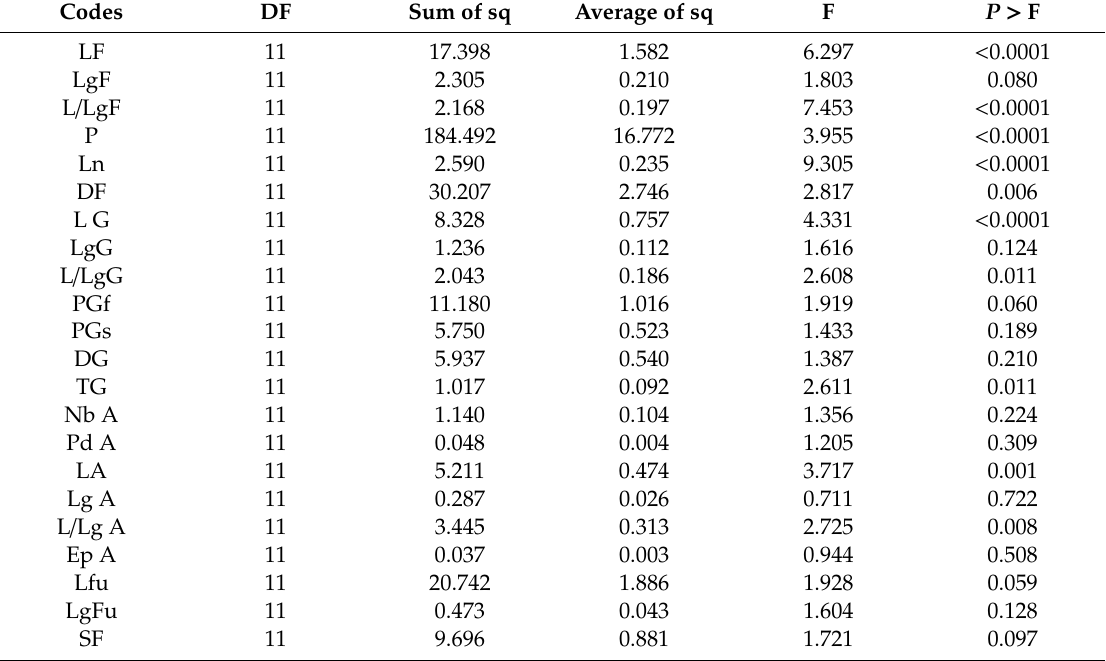
Table 1. Results of analysis of variance (ANOVA) made for comparison of all variables